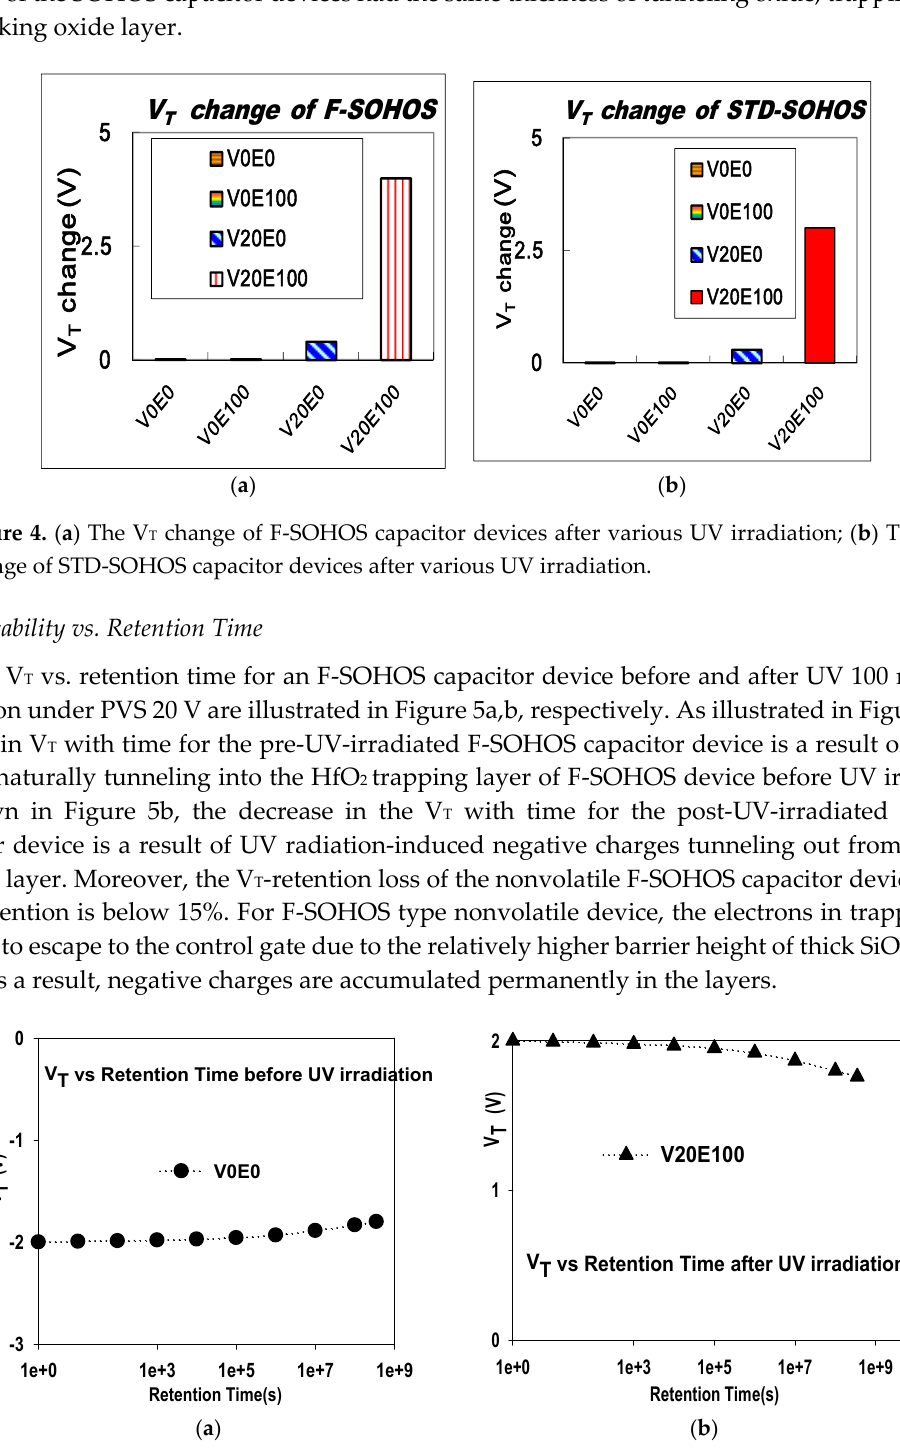
Figure 5. The V T vs. retention time for an F-SOHOS device: ( a ) before UV irradiation; and ( b ) after UV TD 100 mW·s/cm 2 irradiation under gate PVS